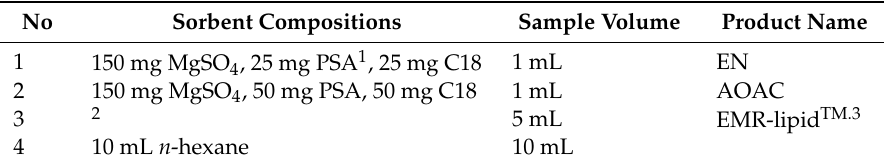
Table 3. List of clean-up procedure investigated in this study. No Sorbent